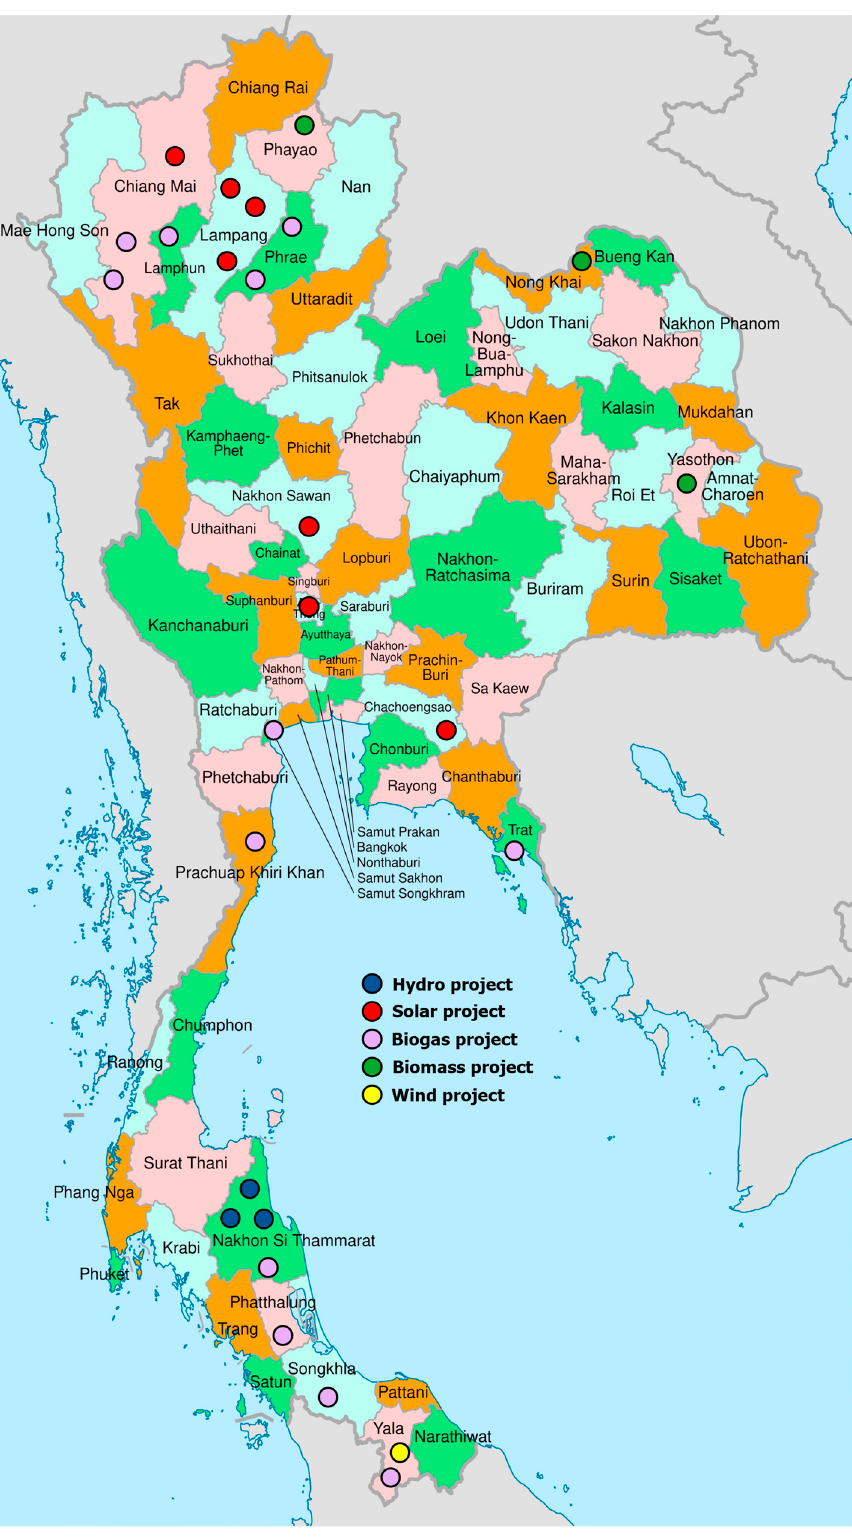
Figure 1. Map showing the geological location of the 26 CRE projects in Thailand: Adapted from [34].